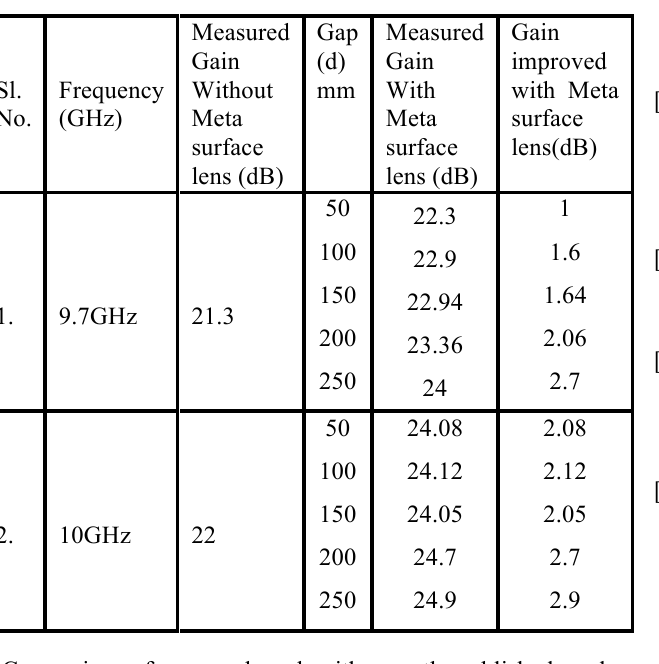
Figure 8: Measured far-field radiation patterns in the (a and b) at E - plane of the horn antenna loaded outside with and without meta surface at 9.7GHz and 10GHz respectively. Table II: Measured power of horn antenna with and without meta surface